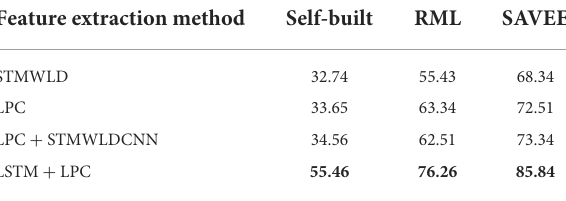
TABLE 1 Expression recognition rate table of each feature extraction algorithm/%. Feature extraction method